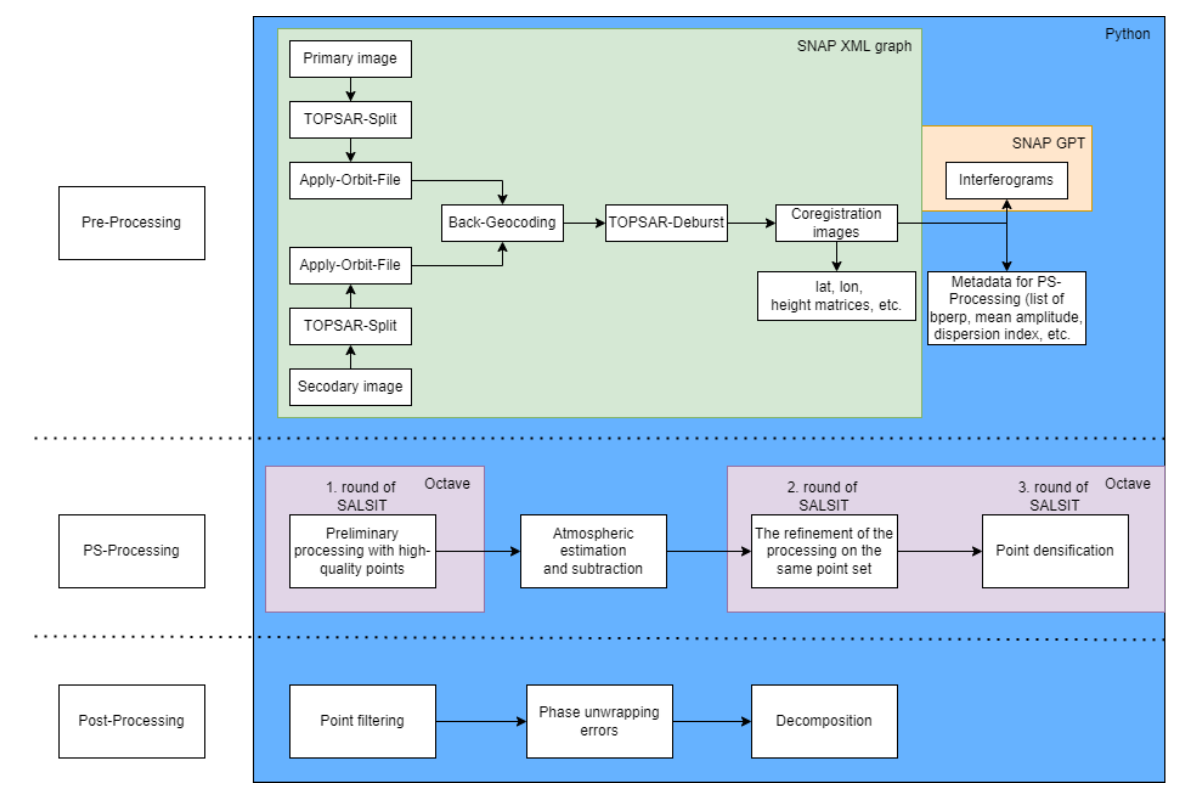
Figure 3. SAR image processing flowchart.